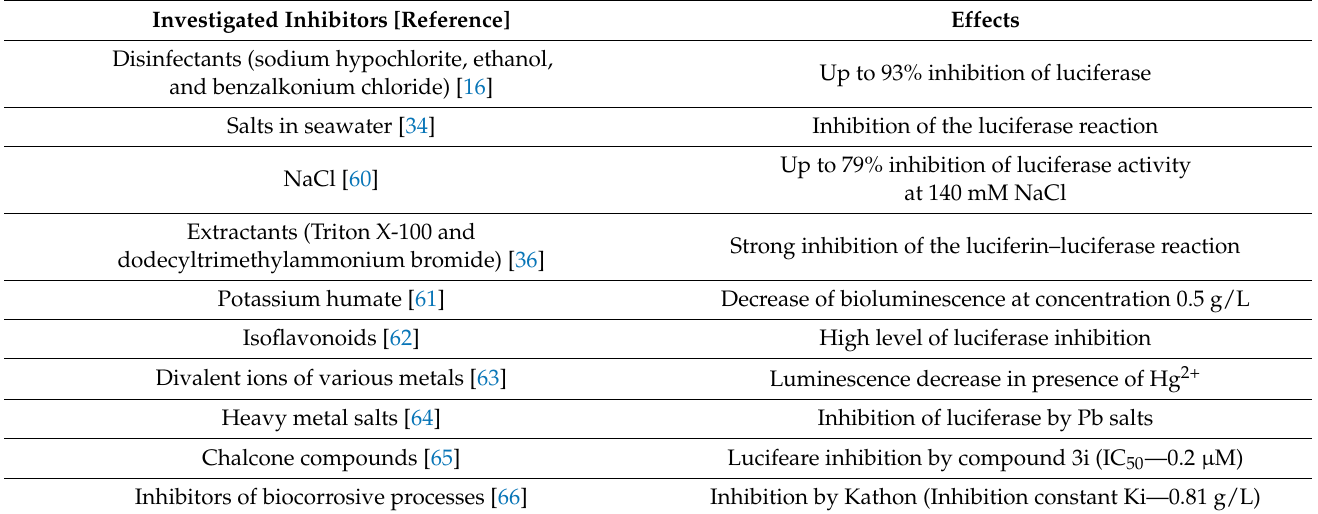
Table 2. The effects of various compounds present in reaction medium of bioluminescent ATP assay on the